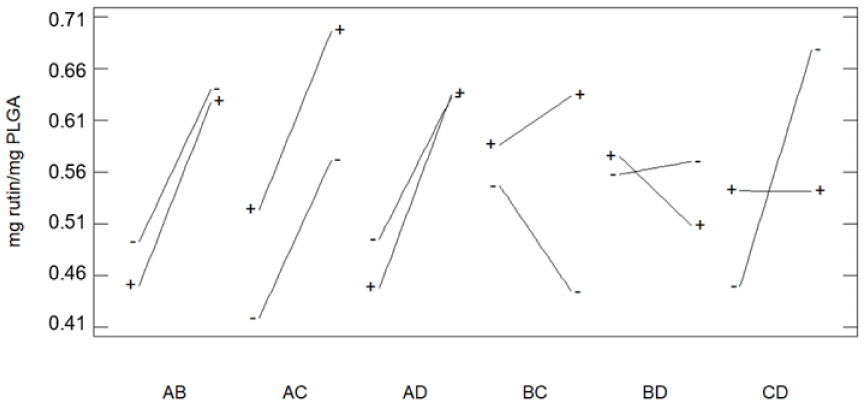
Figure 8. Effect of the interactions between the considered variables on the rutin loads im- pregnated onto the foamed polymer samples (A: Pressure; B: Temperature; C: LA/GA ratio; D: Depressurization